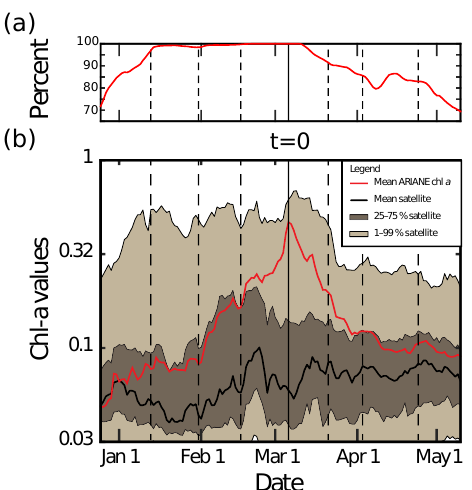
Figure 7. Statistics from ARIANE Lagrangian particle trajectories, from 24 December 2014 to 10 May 2015, with initial date 6 March shown with a solid vertical gray bar and the dates from Fig. 6 in dashed lines. (a) Percentage of particles found inside the bloom region, between 184–192 ◦ E and 22–16 ◦ S. (b) Mean interpolated chl a value for all Lagrangian particles during backward and for- ward integrations is in red, with mean chl a from the CLS dataset in black. Dark shading shows region between 25th and 75th per- centiles, with light shading for the 1st and